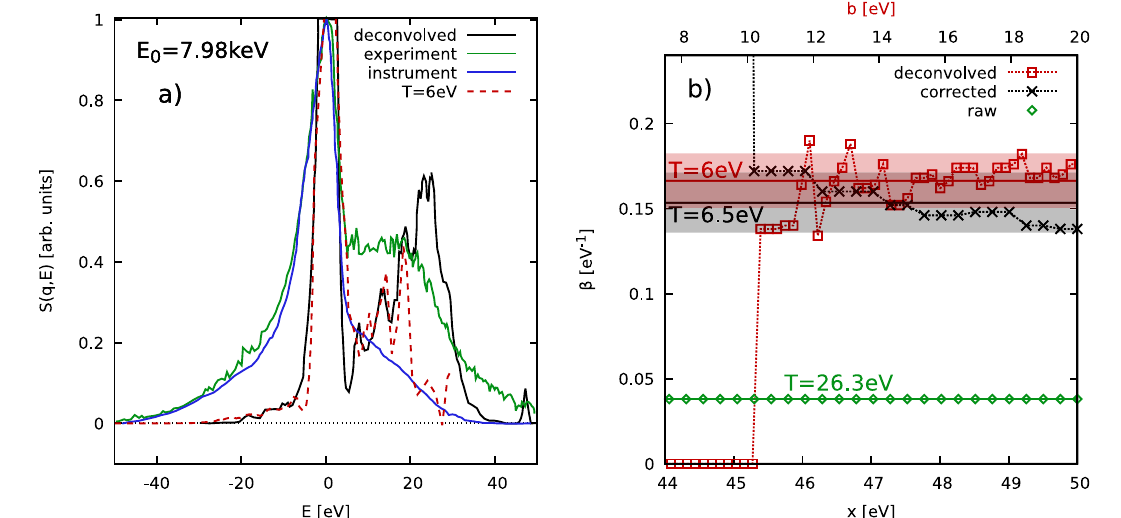
Fig. 3| Temperaturediagnosisofwarm densealuminium. a XRTSmeasurement by Sperling et al. 35 (green), deconvolved dynamic structure factor (black), detailed balance estimation of S ( q , E ) using the nominal value for the temperature of T =6eV (dashed red), and the SIF (blue); b Convergence of the temperature